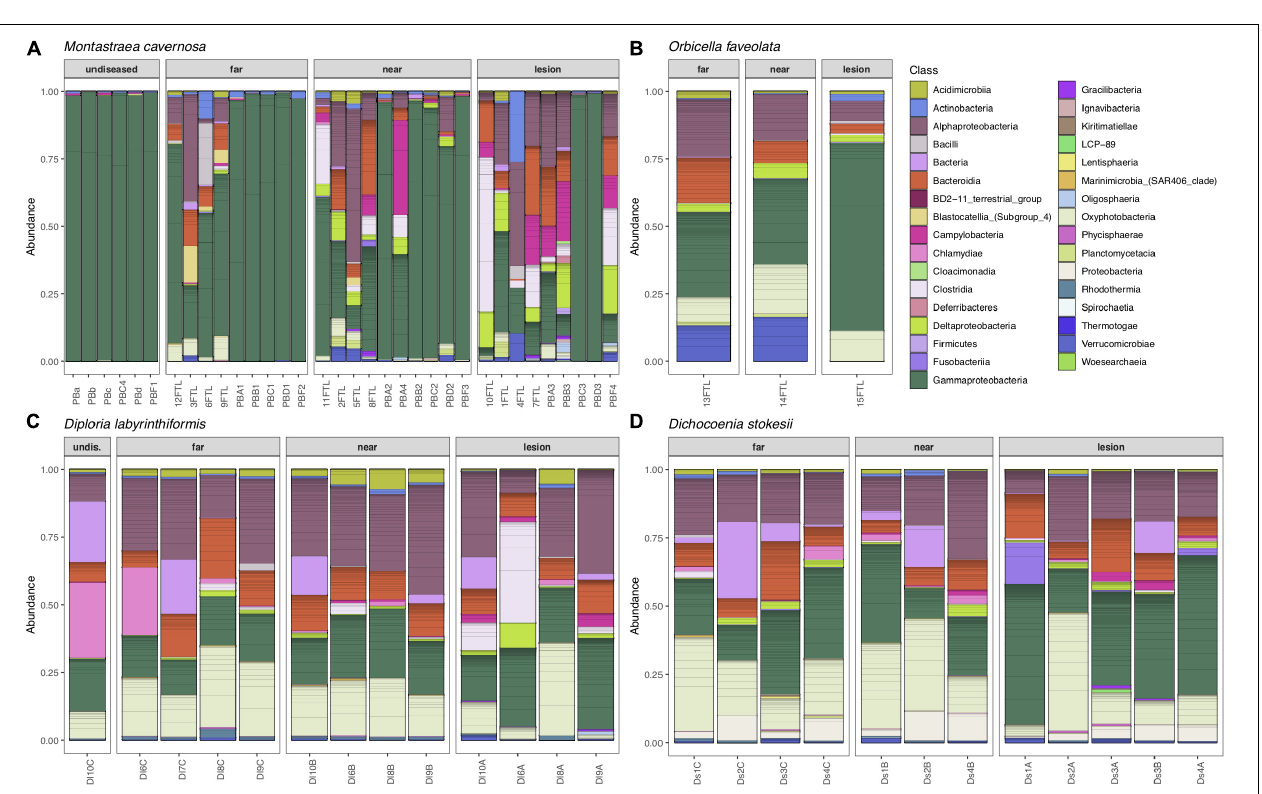
FIGURE 3 | Relative abundance of amplicon sequence variants, colored by Class, in undiseased neighboring corals, apparently healthy tissue far from the disease lesion, apparently healthy tissue near the disease lesion, and disease lesions in Montastraea cavernosa (A) , Orbicella faveolata (B) , Diploria labyrinthiformis (C) , and Dichocoenia stokesii (D) with stony coral tissue loss disease.